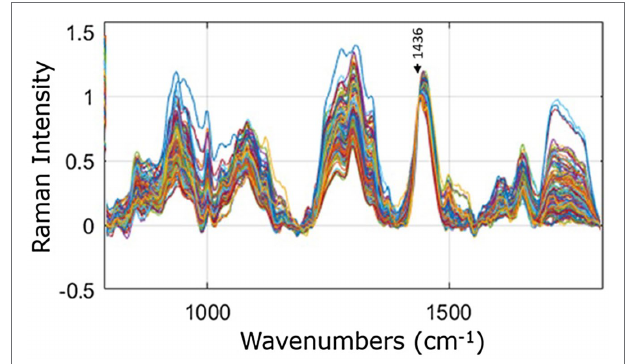
FIGURE 2 | Raman spectra recorded of psoriasis and control sites from all 25 participants, overlaid for comparison and normalised to the peak height at 1,436 cm − 1 , indicated by the arrow.